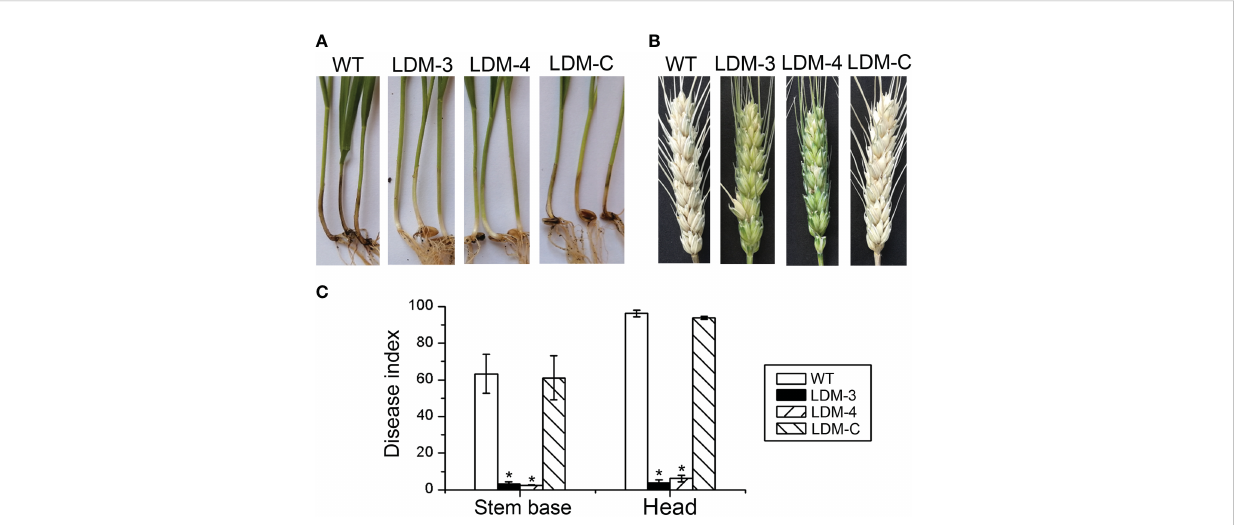
FIGURE 5 Effects of FpLaeB deletion in plant infection. (A) Images were taken when wild-type, FpLaeB deletion mutant, and complemented mutant strains were inoculated to the stem base during the seedling stage at 21 days. (B) Flowering wheat heads inoculated with the different strains were photographed at 21 dpi. (C) Virulence is represented by the disease index. The disease index is calculated from plants with different disease grades. The experiments were repeated three times. Statistical analysis was performed by using Fisher ’ s LSD in SPSS. Asterisks on the bars represent statistically signi fi cant difference compared to wild type ( p <